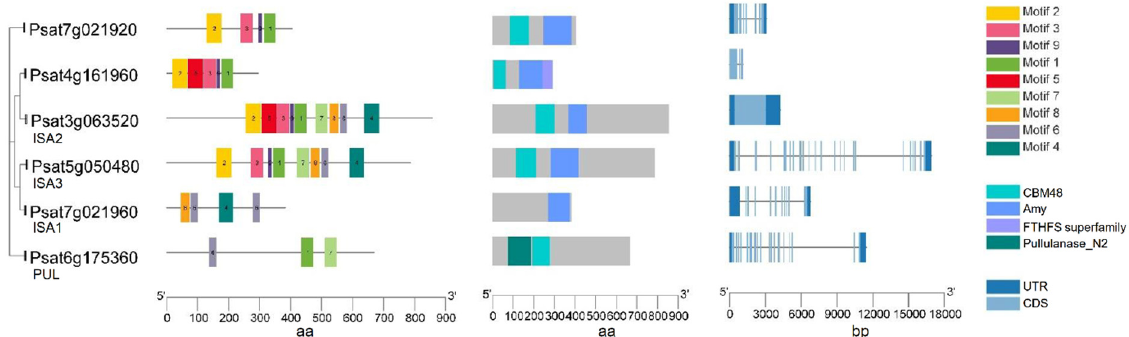
Figure 5. Gene structure, functional domains and conserved motifs in putative starch de-branching enzyme isoamylase (ISA) isoforms and pullulanase (PUL) in pea. Domains identified are carbohydrate-binding module family 48 (CBM48) domain, α -amylase (Amy) domain, FTHFS superfamily domain and Pullulanase_N2 domain.